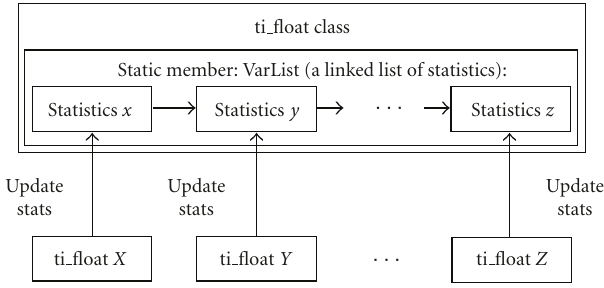
Figure 5: ti float class